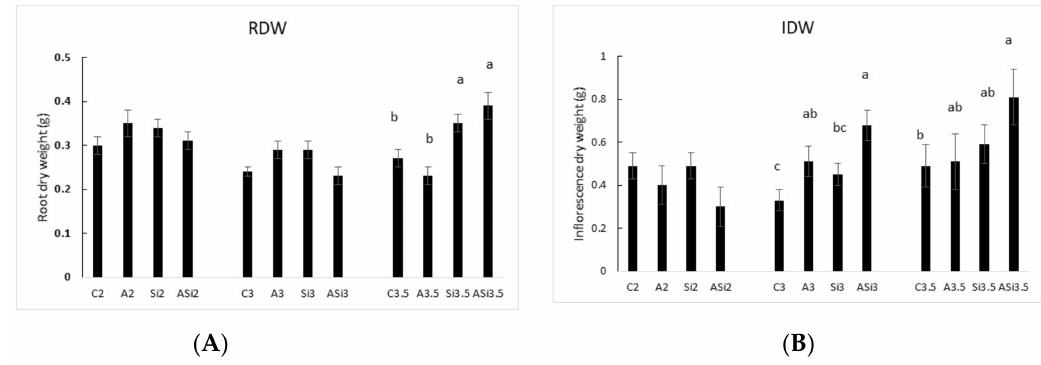
Figure 6. RDW ( A ) and IDW ( B ) (g) at the end of the trial for the C2 (foliar application with water and fertigation EC 2.0 dS m − 1 ), A2 (foliar application with Arthrospira platensis and fertigation EC 2.0 dS m − 1 ), Si2 (foliar application with Si and fertigation EC 2.0 dS m − 1 ), ASi2 (foliar application with Arthrospira platensis and Si, and fertigation EC 2.0 dS m − 1 ), C3.0 (foliar application with water and fertigation EC 3.0 dS m − 1 ), A3.0 (foliar application with Arthrospira platensis and fertigation EC 3.0 dS m − 1 ), Si3 (foliar application with Si and fertigation EC 3.0 dS m − 1 ), ASi3 (foliar application with Si and Arthrospira platensis, and fertigation EC 3.0 dS m − 1 ) treatments; C3.5 (foliar application with water and fertigation EC 3.5 dS m − 1 ), A3.5 (foliar application with Arthrospira platensis and fertigation EC 3.5 dS m − 1 ), Si3.5 (foliar application with Si and fertigation EC 3.5 dS m − 1 ), and ASi3.5 (foliar application with Si and Arthrospira platensis, and fertigation EC 3.5 dS m − 1 ) treatments. Di ff erent letters indicate significant di ff erences between treatments at the p < 0.05 level using the LSD test. Values are the means of 12 plants. Error bars show standard deviations.